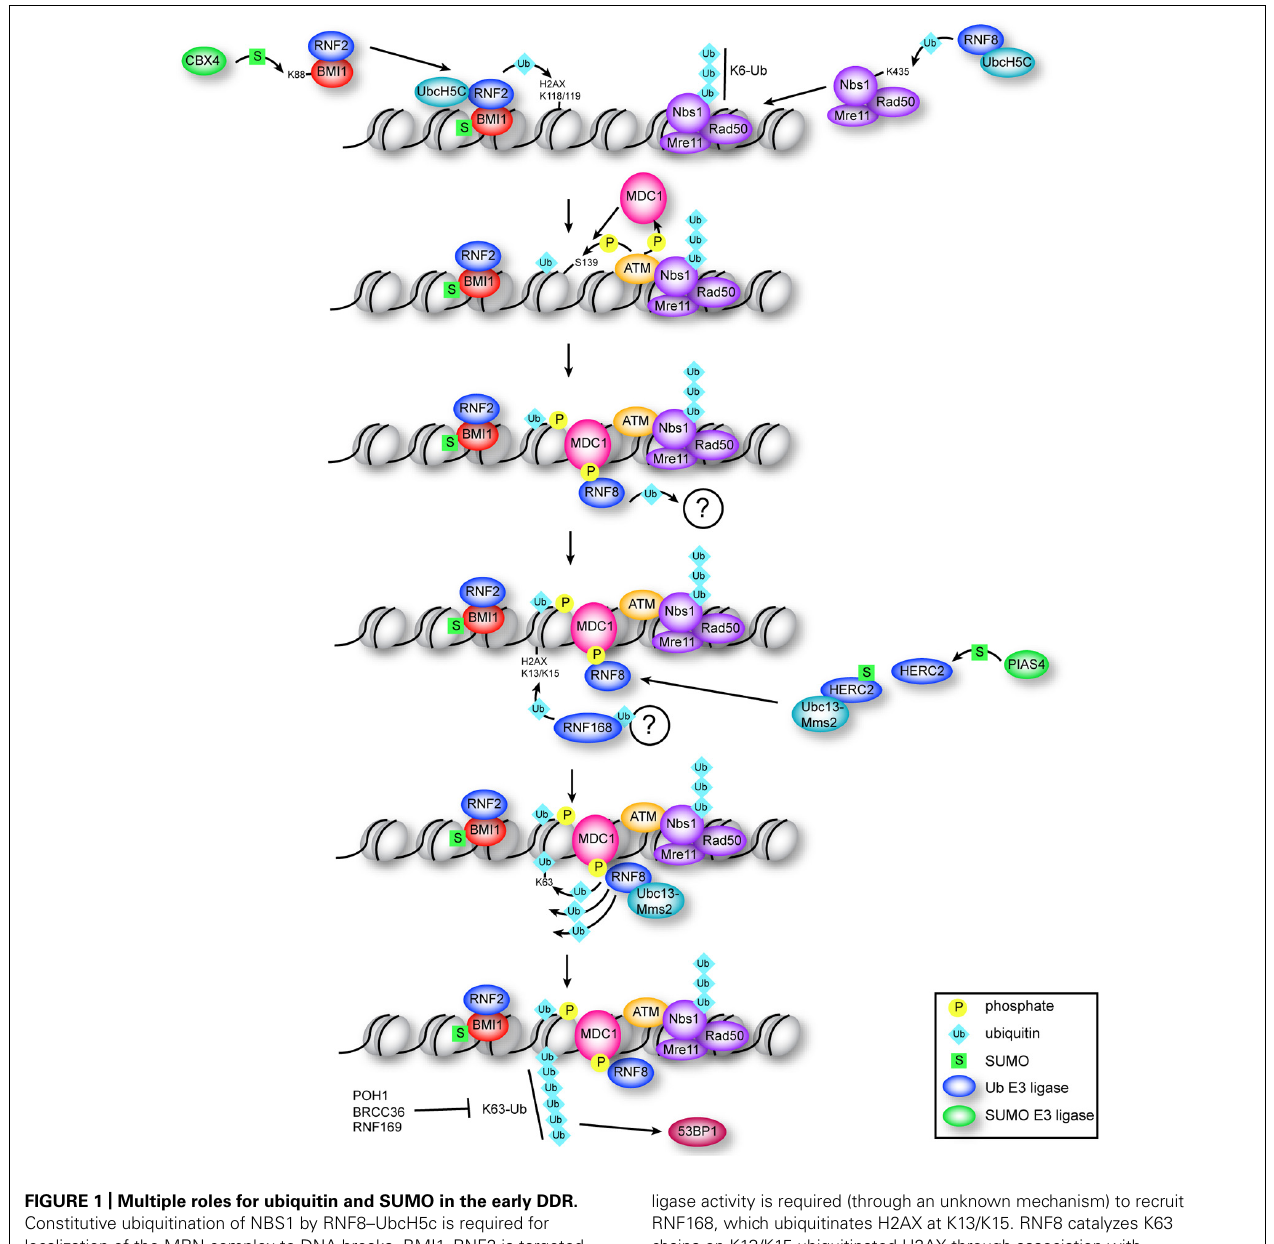
FIGURE 1 | Multiple roles for ubiquitin and SUMO in the early DDR. Constitutive ubiquitination of NBS1 by RNF8–UbcH5c is required for localization of the MRN complex to DNA breaks. BMI1–RNF2 is targeted to DSBs by damage-induced CBX4-mediated sumoylation of BMI1. RNF2–BMI1–UbcH5c monoubiquitinates H2AX on K118/K119, which is required for recruitment of ATM and efficient production of γ -H2AX. MDC1 binds γ -H2AX and is phosphorylated by ATM, which recruits RNF8.